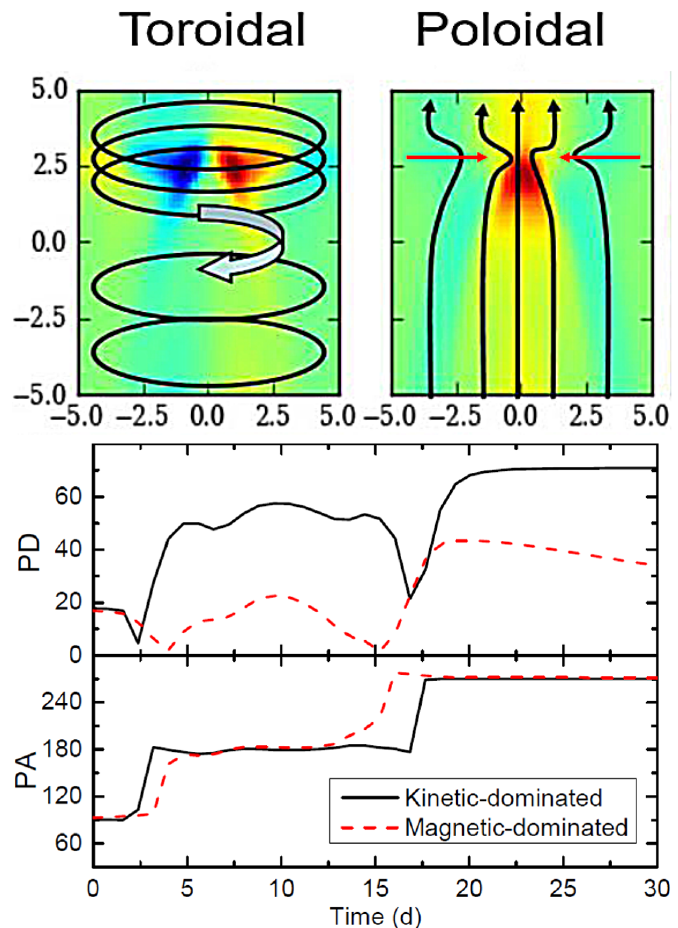
Figure 3. Top : sketch and simulation results of the toroidal and poloidal magnetic field components under shock compression. Left panel shows that the toroidal component is compressed at the shock front. Right panel shows the toroidal component is squeezed by the excess magnetic force due to the toroidal magnetic field compression. Bottom : time-dependent polarization signatures of kinetic-dominated and magnetic-dominated jet emission environment. Upper panel is the polarization degree and the lower panel is the polarization angle. The calculation is based on combining magnetohydrodynamics (MHD) simulation (LA-COMPASS) with polarization-dependent radiation transfer (3DPol). Figure is reproduced from